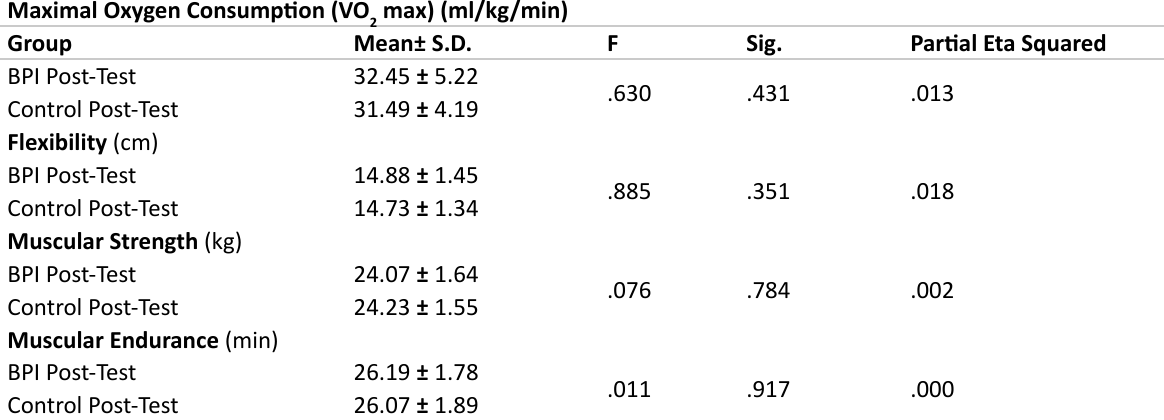
Table 4. Analysis of covariance (ANCOVA) results regarding the health-related components of physical fitness including maximal oxygen consumption (VO2 max), flexibility, muscular strength, and muscular endurance.